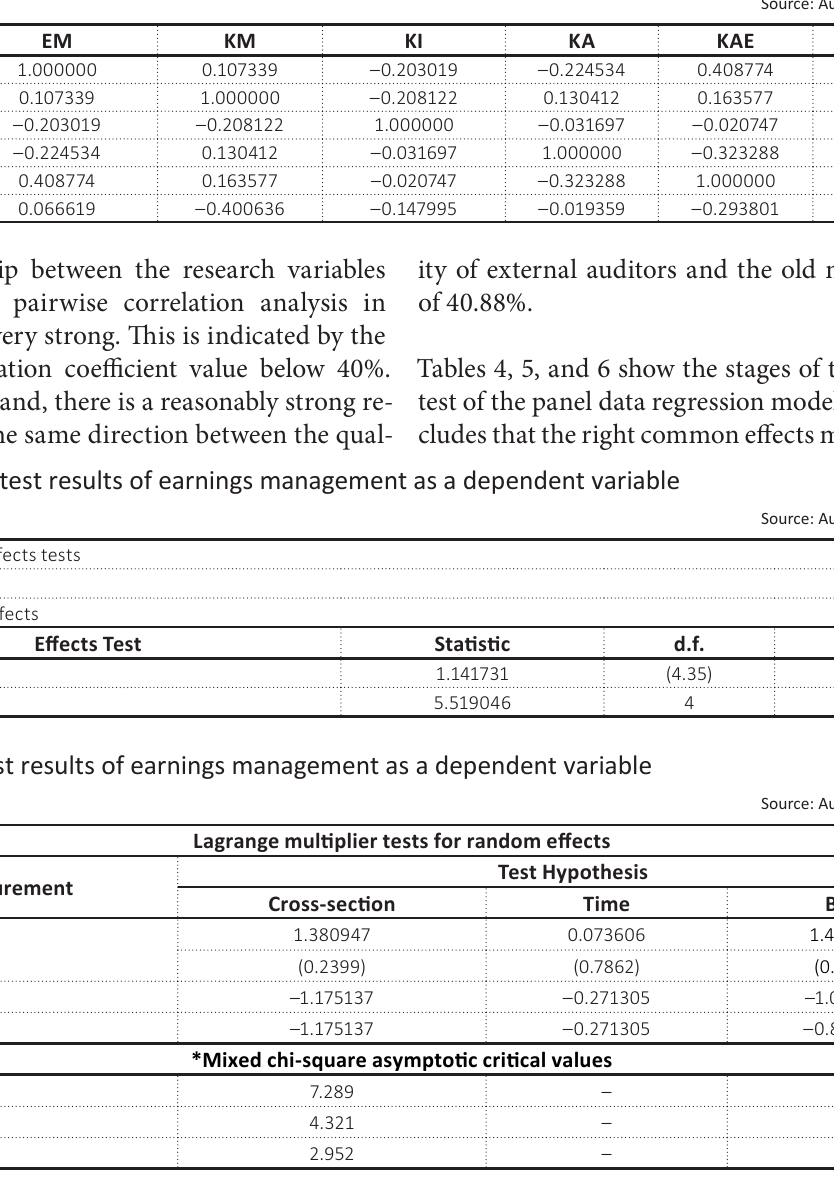
Table 3. Correlation analysis